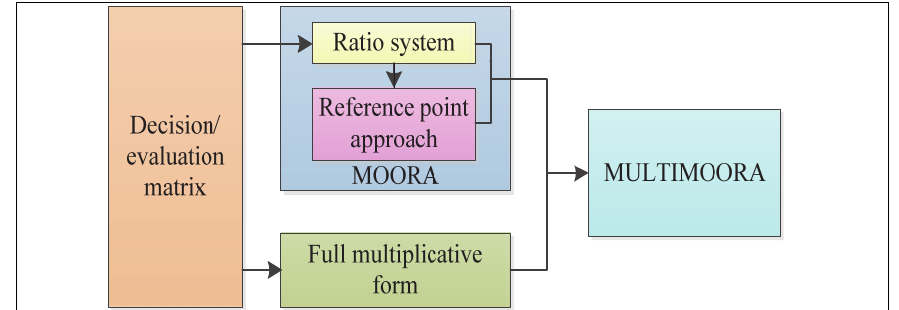
Fig. 1. Procedural diagram of